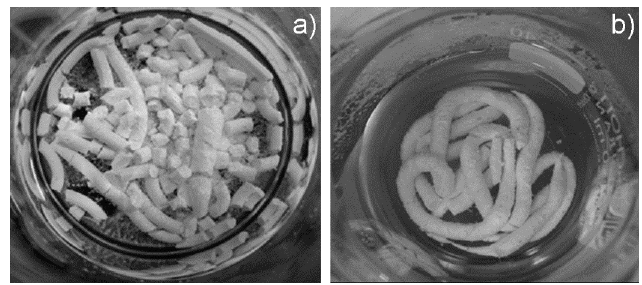
Figure 3. Cohesion of the cements after 30 min of immersion in Hanks’ balanced salt solution at 37 °C. ( a ) Sr5 without alginate; and ( b ) Sr5 with alginate.